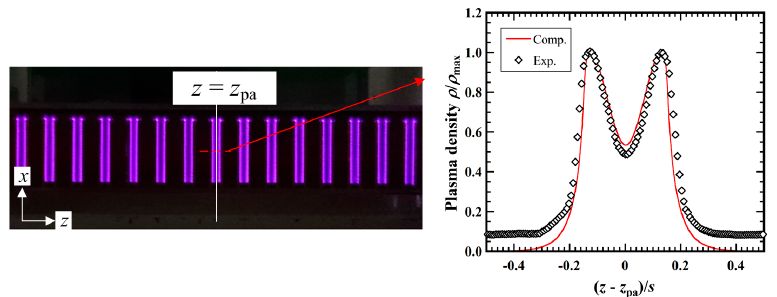
Figure 7. Plasma distributions. Photograph of the plasma luminescence ( left ). Predicted distributions of plasma density near the wall ( y = 0.05 mm), compared with those determined from the plasma luminescence in the photograph ( right ).